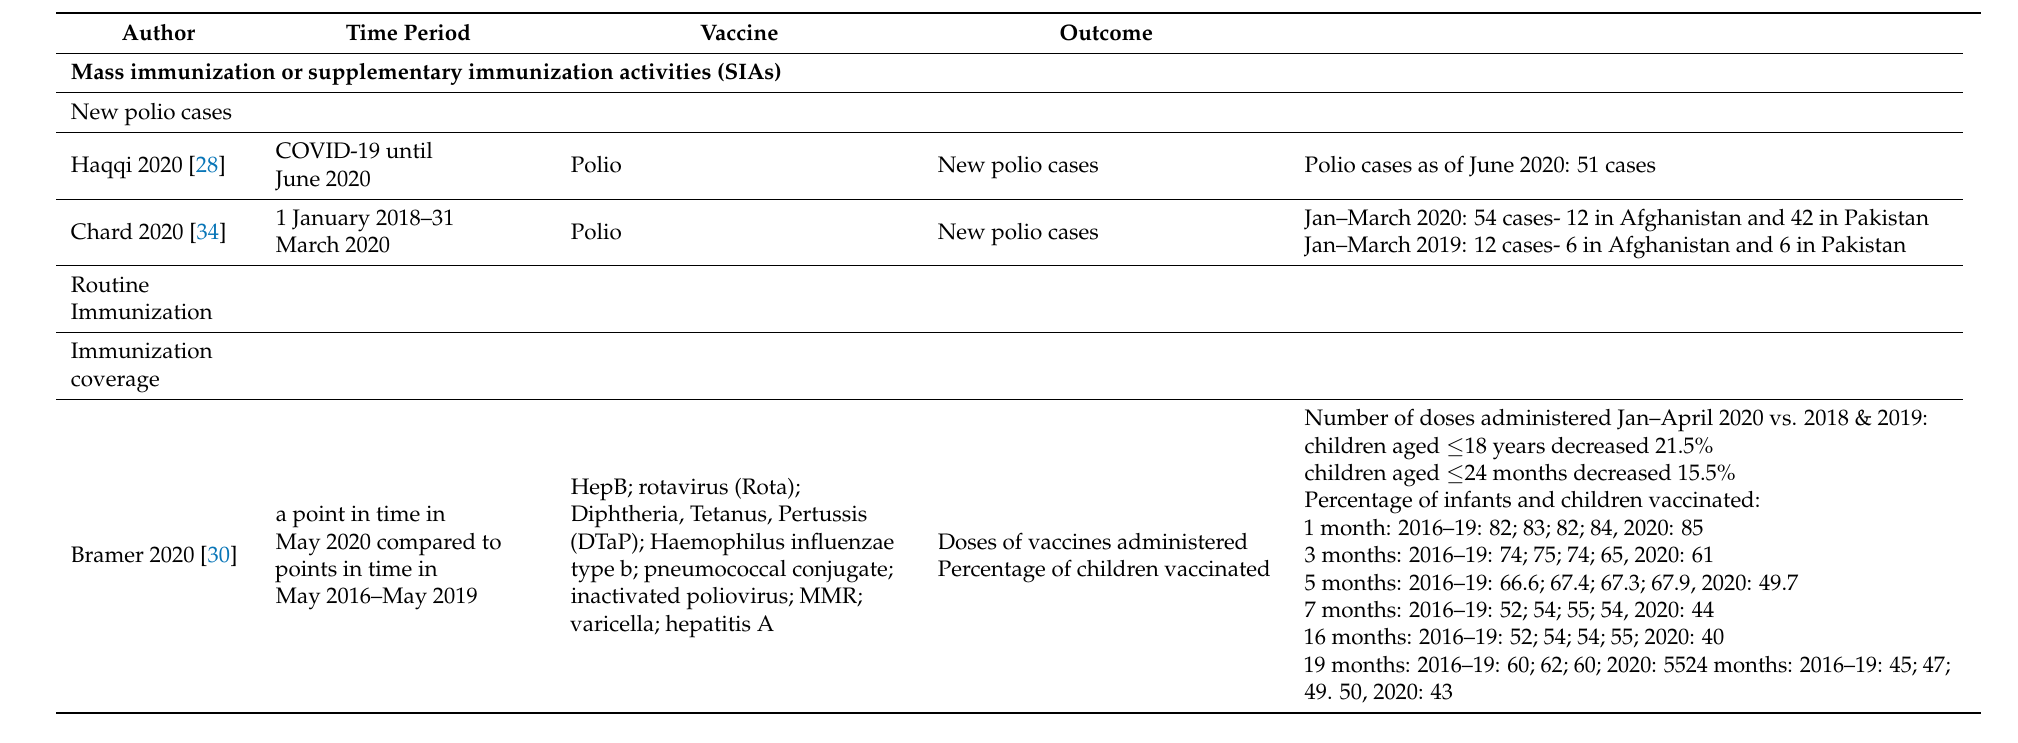
Table 2. Outcomes reported in the included